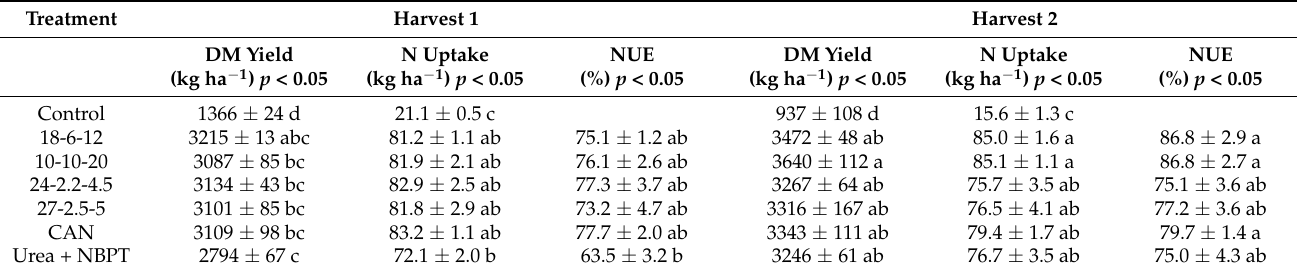
Table 4. Mean ± SE values of dry matter (DM) yield, N uptake, and Nitrogen use efficiency (NUE) from two individual harvests following fertiliser applications. Treatment Harvest